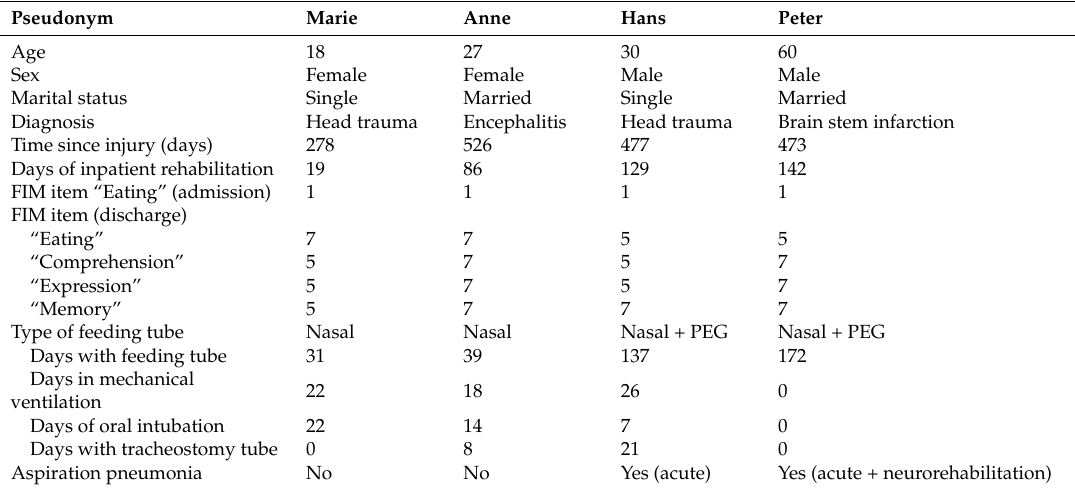
Table 1. Clinical characteristics of the four